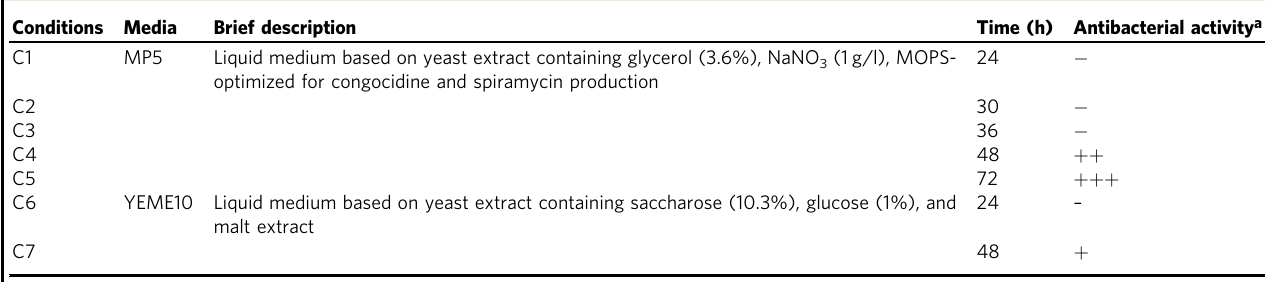
Table 1 Growth conditions used to perform -omics analyses.